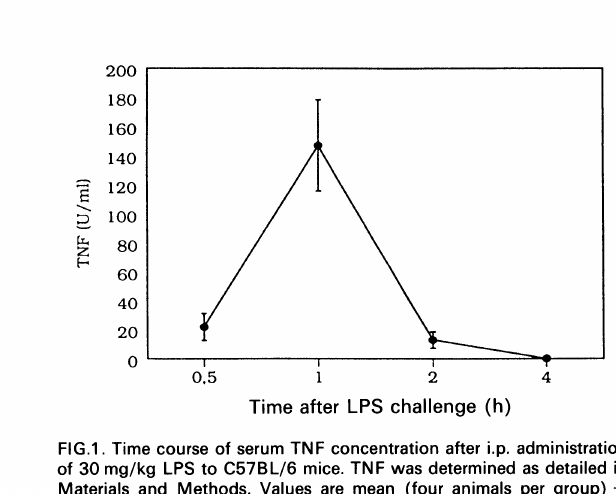
FIG.1. Time course of serum TNF concentration after i.p. administration of 30 mg/kg LPS to C57BL/6 mice. TNF was determined as detailed in Materials and Methods. Values are mean (four animals per group)-I- standard deviation.